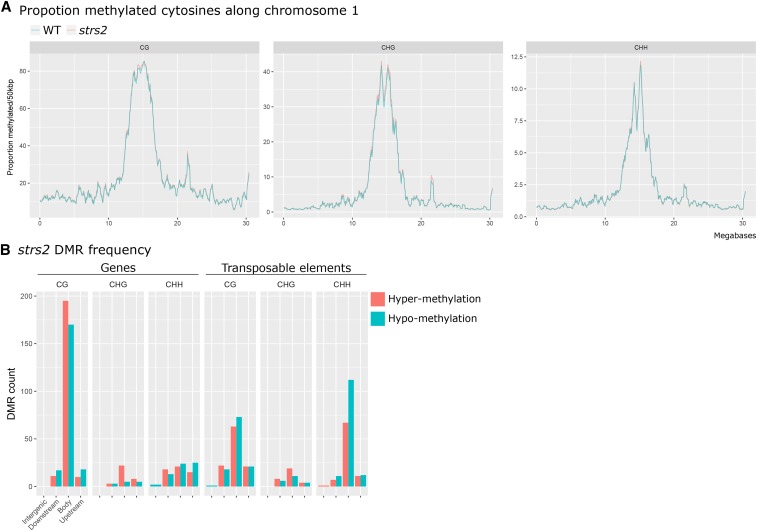
Subtle methylome perturbation in strs2 A Mean weighted methylation levels, binned into 50 kbp rolling windows, along Arabidopsis chromosome 1 for WT and strs2. B DMR frequency in strs2 grouped by genomic location relative to annotated genes or transposable elements. DMRs were classified as either occurring directly within (body), <1 kbp away from the 5` (upstream) or 3`end of (downstream), or >1 kbp (intergenic) away from genomic features.